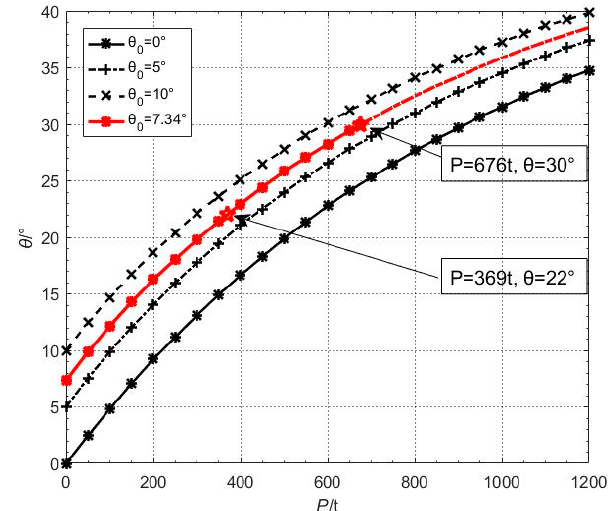
Figure 7. The firewater accumulation of the M/V Dashun accident.